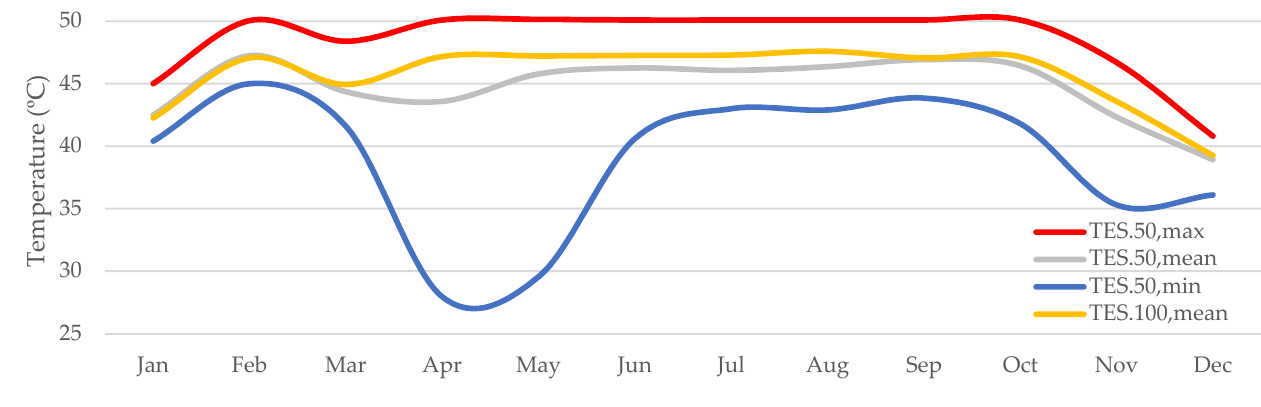
Figure 19. Monthly median daily TES KPIs.